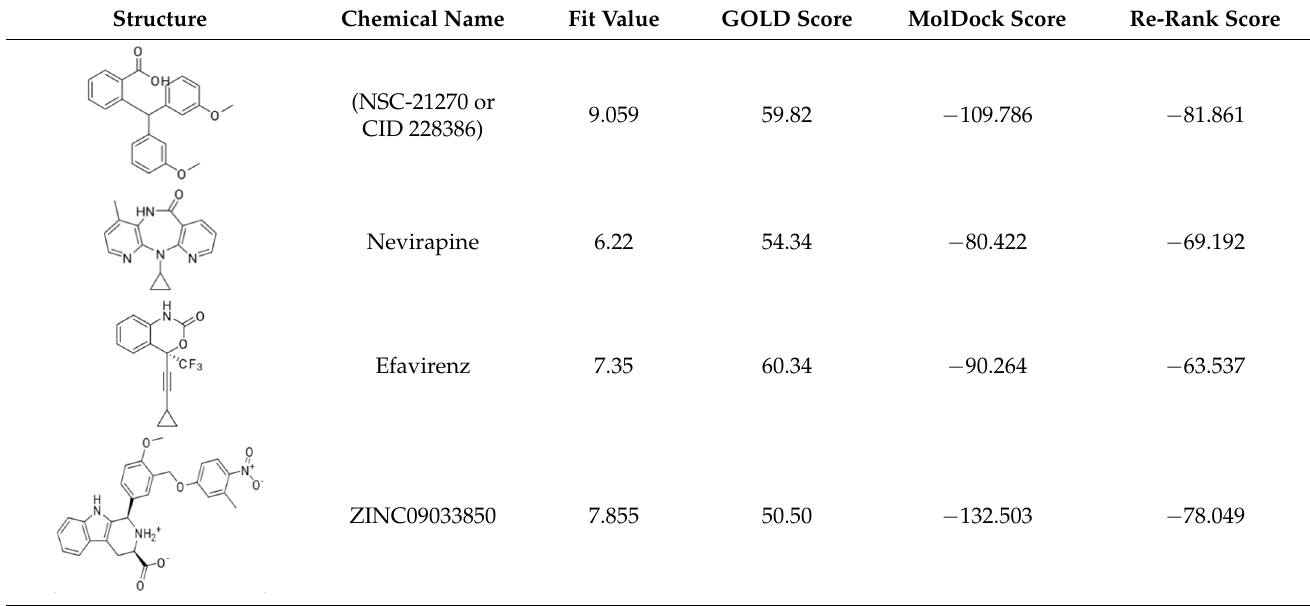
Figure 8. ( A , B ). The comparative docking of screened ( A ) ligand (NCI-21270) and ( B ) Nevirapine as a standard drug shows butterfly conformation and important hydrophobic interactions, along with hydrogen-bond interactions with Lys101 and other important residues in the NNRTI’s binding site. Table 3. Docking scores of reference compounds and the final hits obtained after the docking study. Structure